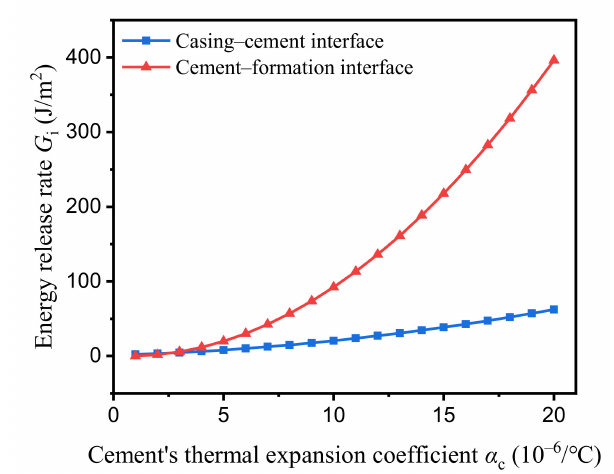
Figure 6. Evolution of the energy release rate at interfaces with cement’s thermal expansion coe ffi cient.